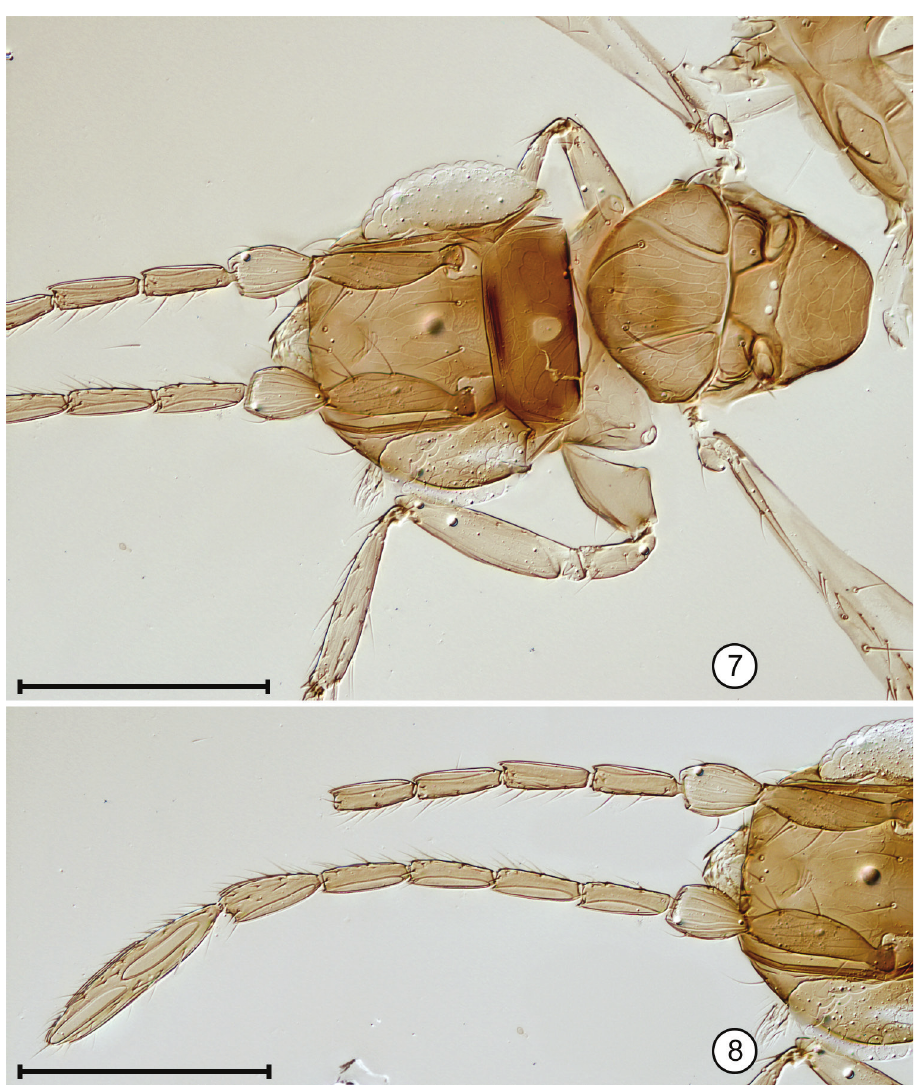
Figures 7, 8. Anaphes quinquearticulatus , holotype 7 head + mesosoma 8 antennae. Scale bars: 100